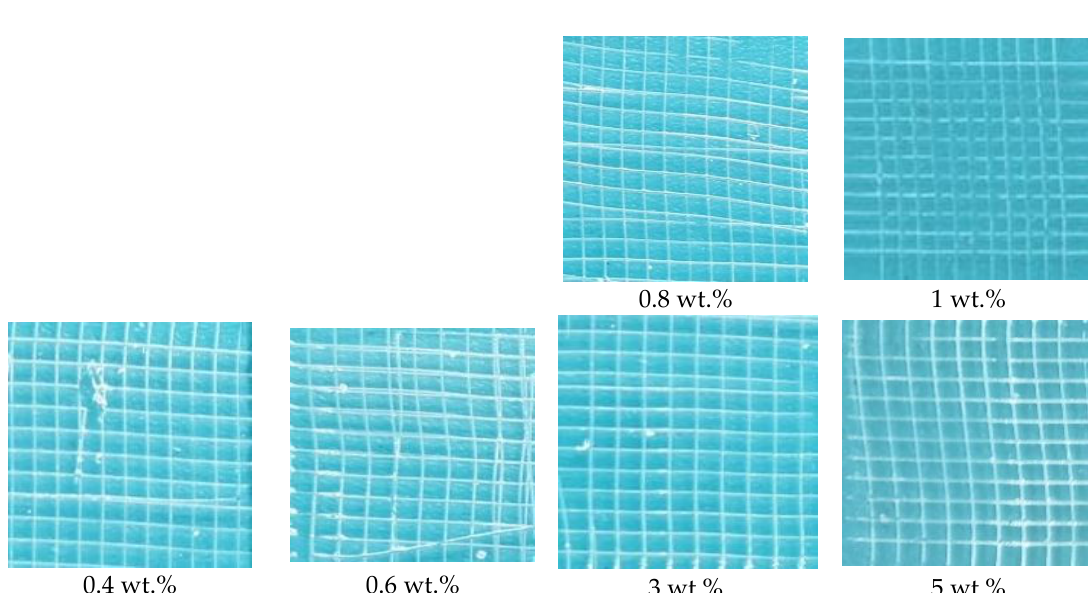
Figure 8. Photos of adhesive tests of coatings cured with various amount of thiol silicone resin with thiol content of 5 mmol g −1.